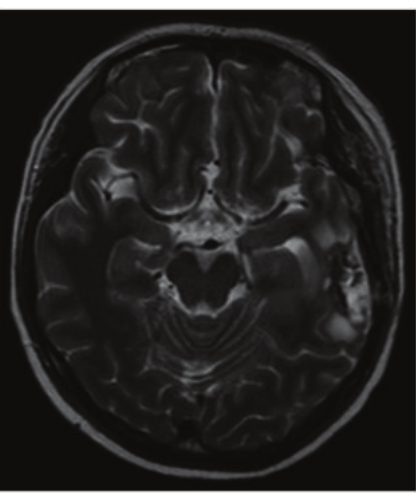
Figure5:Brainmagneticresonanceimaging(horizontal)indicating the absence of the metastatic tumor after urgent craniotomy and chemoradiation.